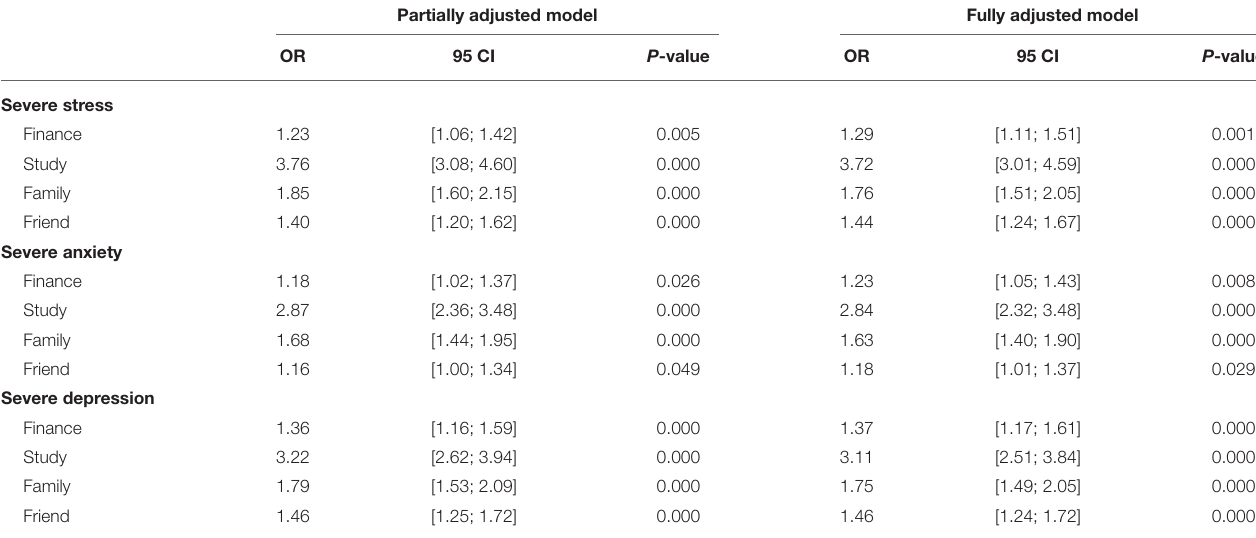
TABLE 3 | Relationship between FSFF scale and severe symptoms of mental disorders